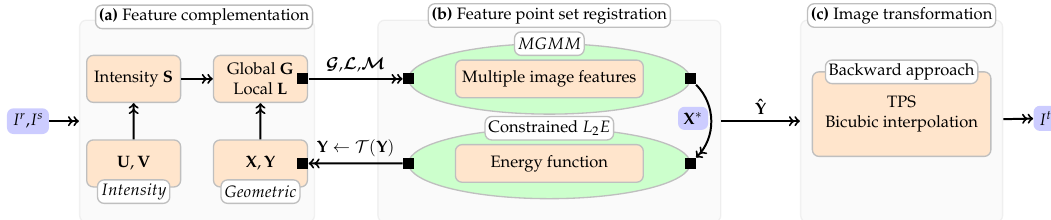
Figure 5. The summary of our method. ( a ): Extracting putative corresponding set { x i , y i } n SIFT descriptor set { u i , v i } n using SIFT algorithm, and obtaining two types of discrepancies, i.e., the i = 1 global and local geometric structure discrepancies G and L , and intensity information discrepancy S